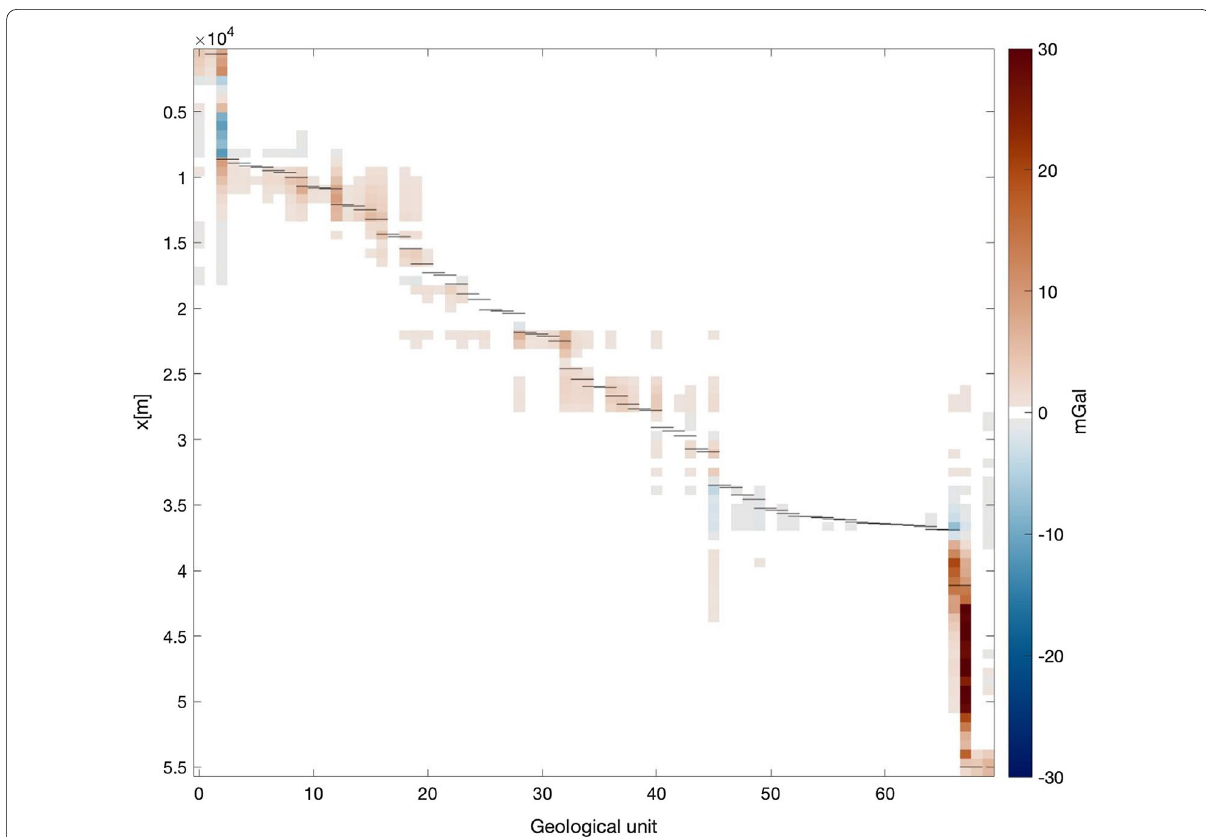
Fig. 10 Terrain-adaptation gravity correction due to each geological unit (ranging from North to South on the x-axis) and as a function of the selected surface gravity points (shown at their location along the model line on the y-axis from North (top) to South (bottom)). The gravity values shown here are for a reference density of 1000 kg · m − 3 . The variations depicted here depend on each unit’s geometry and the distance between the unit and the selected gravity point. The mainly diagonal structure indicates that units tend to affect primarily the gravity points close by along the profile, with the exception of the widest units at the beginning and the end of the model line. For given units (i.e. along a single column) some gaps are present between non-zero values, due to the different elevation change between the unit and the gravity points. The thin horizontal lines, plotted for each unit along the y-axis indicate the northern and the southern boundary of the associated unit, hence showing how far beyond its own boundaries a geological unit is affecting the gravity points